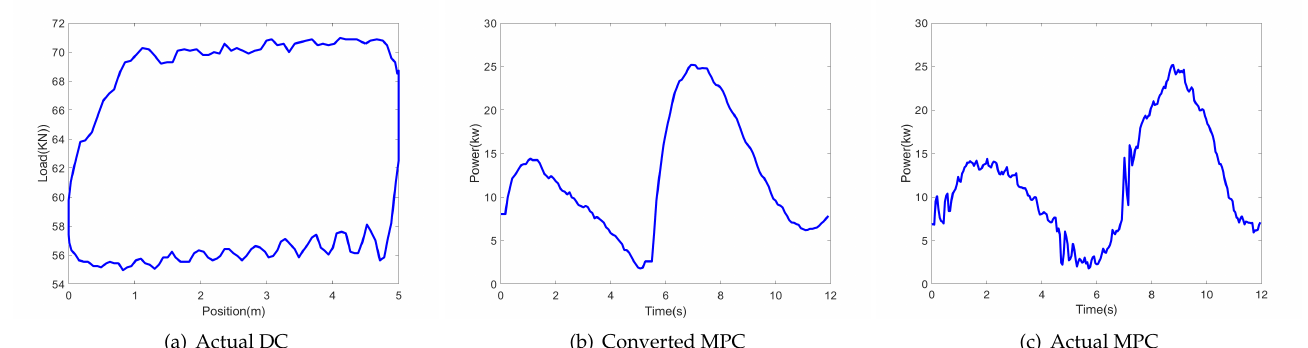
Figure 7. Traveling valve leakage working state.